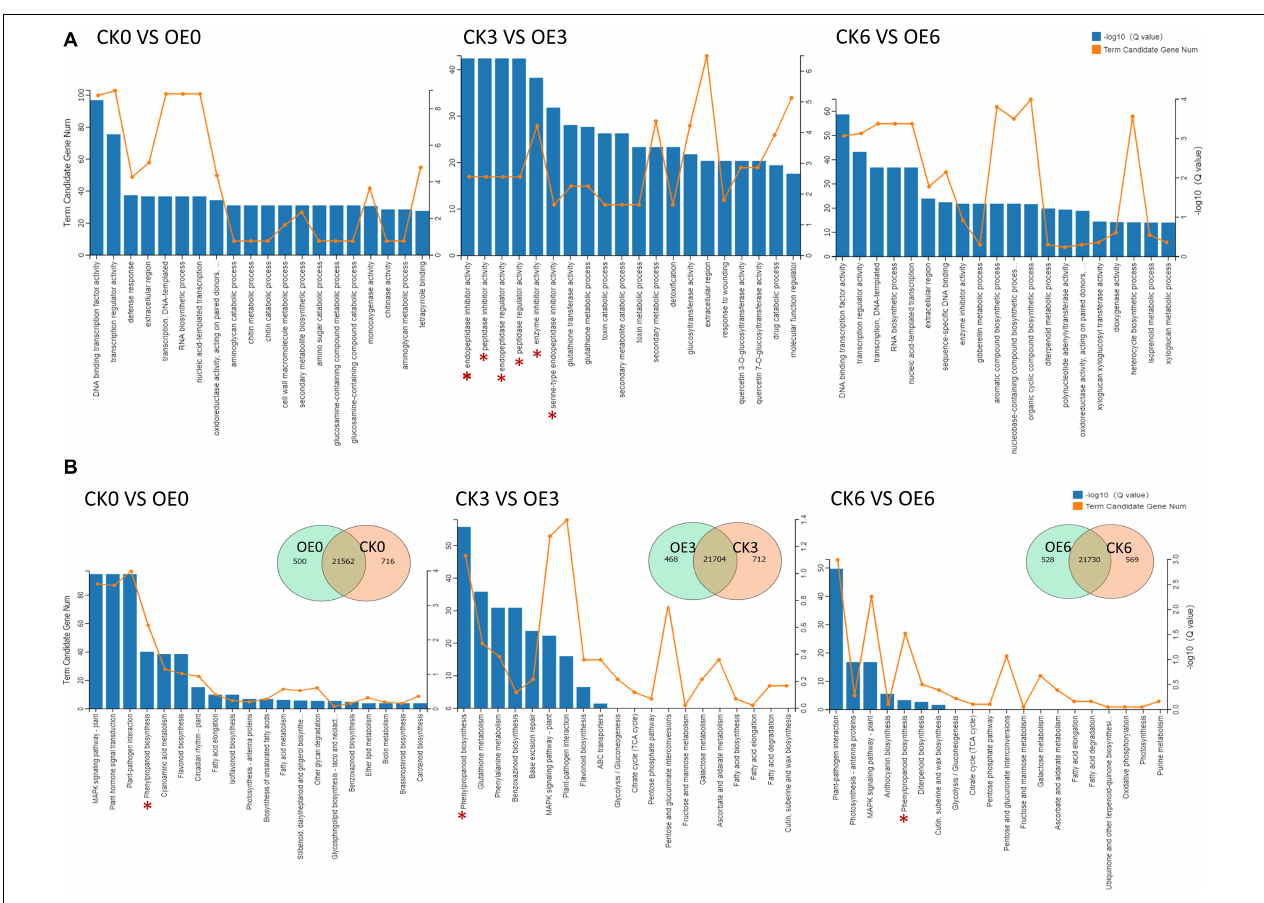
FIGURE 7 | (A) GO annotation of DEGs at three time points. The asterisks represent the items of inhibiting or regulating protein degradation. (B) KEGG analysis and comparison of DEGs between WT and OE lines at three time points under drought stress. WT represents WT plants, and OE represents overexpression lines. The pentacle represents the phenylpropanoid biosynthesis